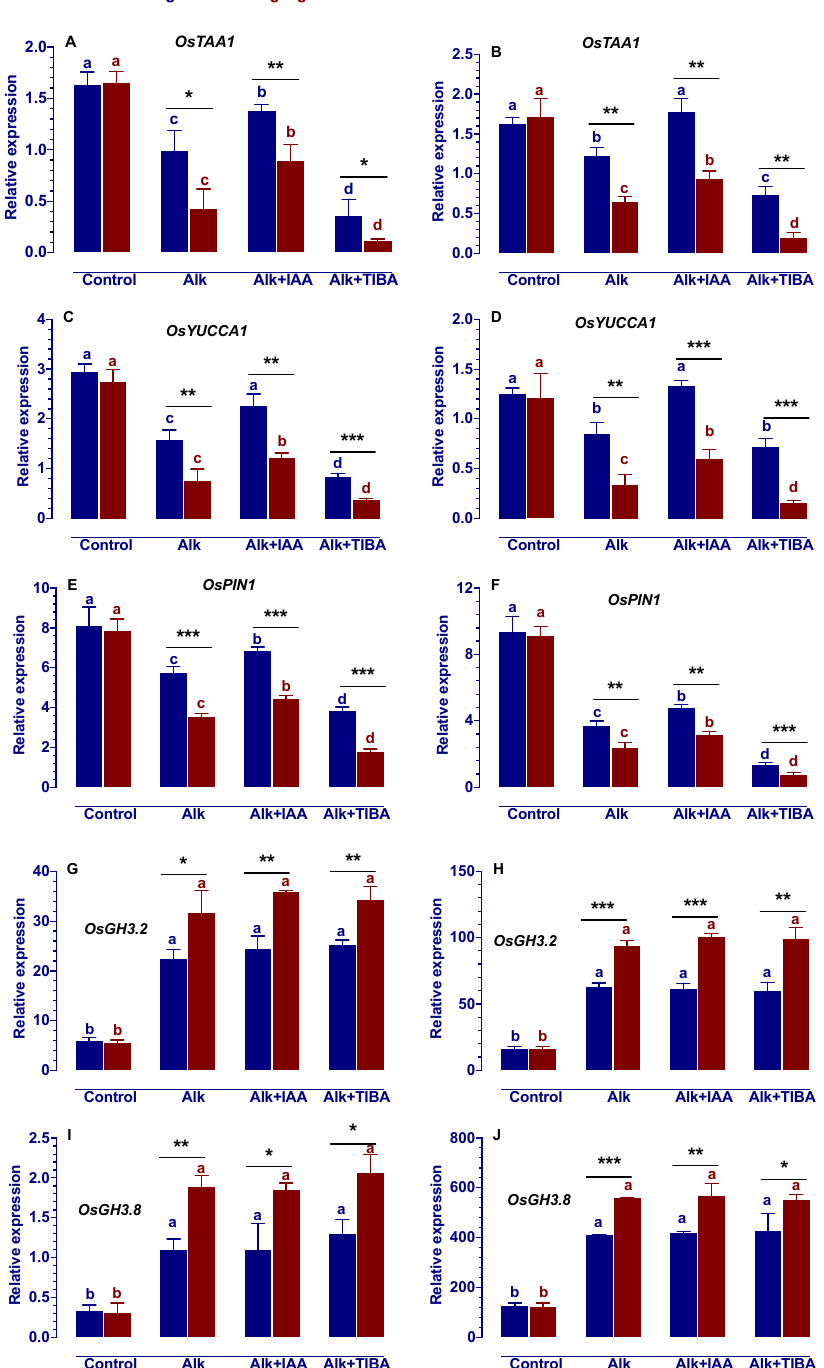
Figure 7. Effects of alkaline stress on the expression of genes involved in IAA biosynthesis (O sTAA1 and OsYUCCA1 ), transport ( OsPIN1 ) and catabolism ( OsGH3.2 and OsGH3.8 ) in shoots ( A , C , E , G , I ) and roots ( B , D , F , H , J ) of Dongdao-4 and Jigeng-88 seedlings. Treatments were as described in Figure 1. Means with different letters are significantly different ( p < 0.05) between control and “Alk” and “Alk + IAA” and “Alk + TIBA” of the same genotype. Asterisks indicate significant differences between different genotypes within the same treatment (* p < 0.05, ** p < 0.01, *** p < 0.001).